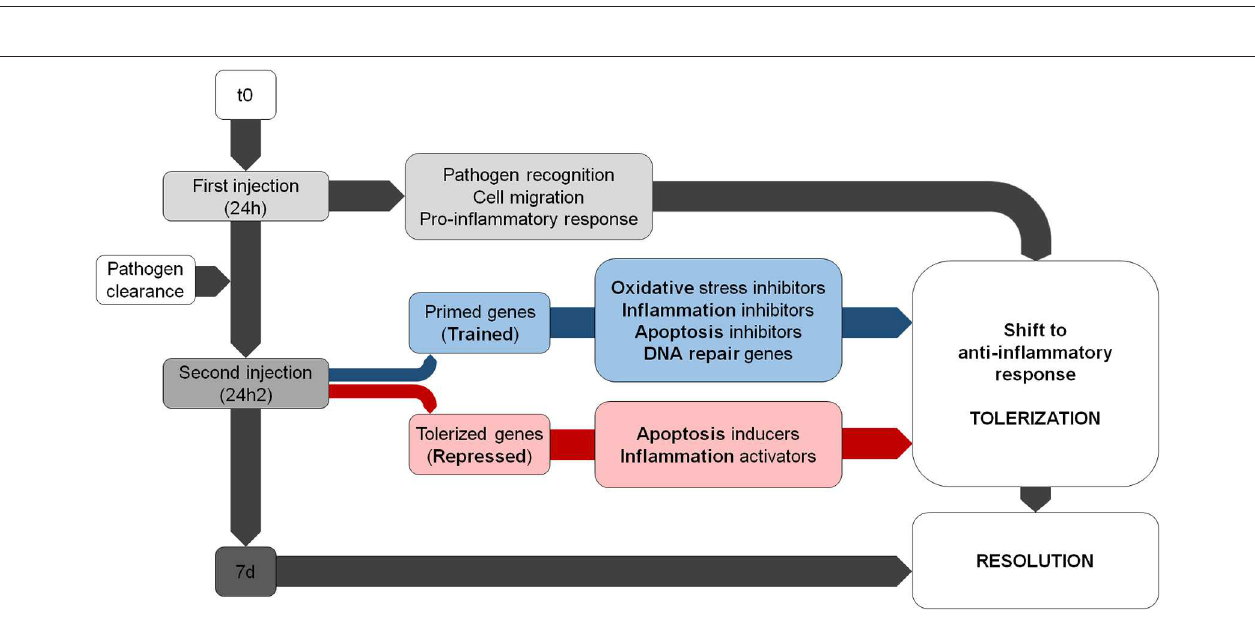
FIGURE 8 | Summary of the main biological processes regulated during the subsequent Vibrio challenges. Note that the trained genes shift in terms of response from pro- to anti-inflammatory.